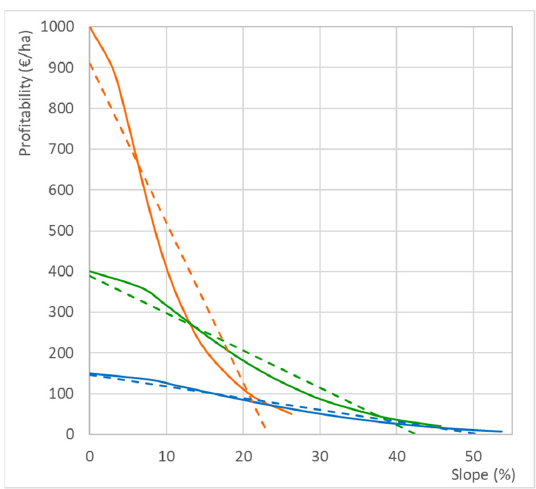
Figure 3. Profitability curves for agriculture (orange), forest (green), and shrubland (blue) as a function of slope in the study area (solid lines—observed curves; dashed lines—fitted models).